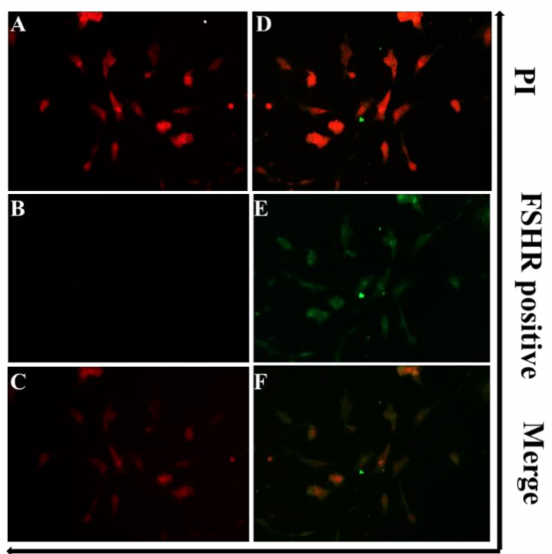
Figure 2. Identification of granulosa cells (GCs). PI was used for staining the cellular nuclei ( A , D ). The cultured cells were FSHR positive ( E ). ( B ) Negative control. ( C ) is the merged image of ( A ) and ( B ). ( F ) is the merged image of ( D ) and ( E ). Original magnification × 100.